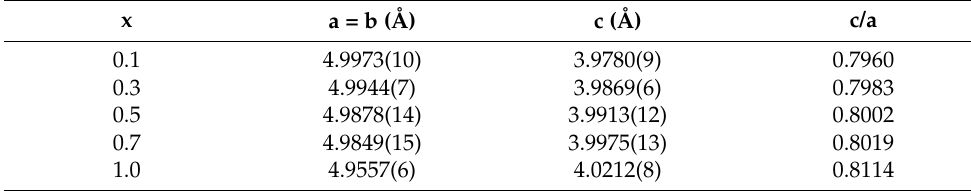
Table 1. Unit Cell Parameters for Sm 1 − x (Ce 0.75 La 0.25 ) x Co 5 (x = 0.1–1.0) main phase.